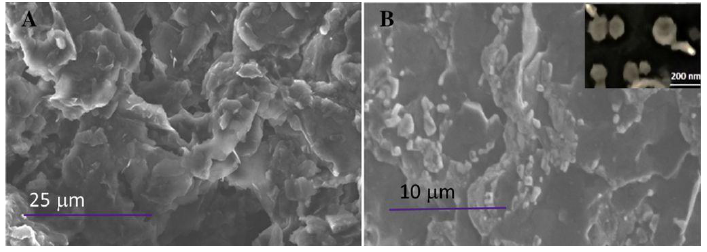
Figure 5. FE-SEM images of: blank SPE ( A ); and bacteriophage immobilized SPE ( B ). Reproduced from [99] with permission from Elsevier.